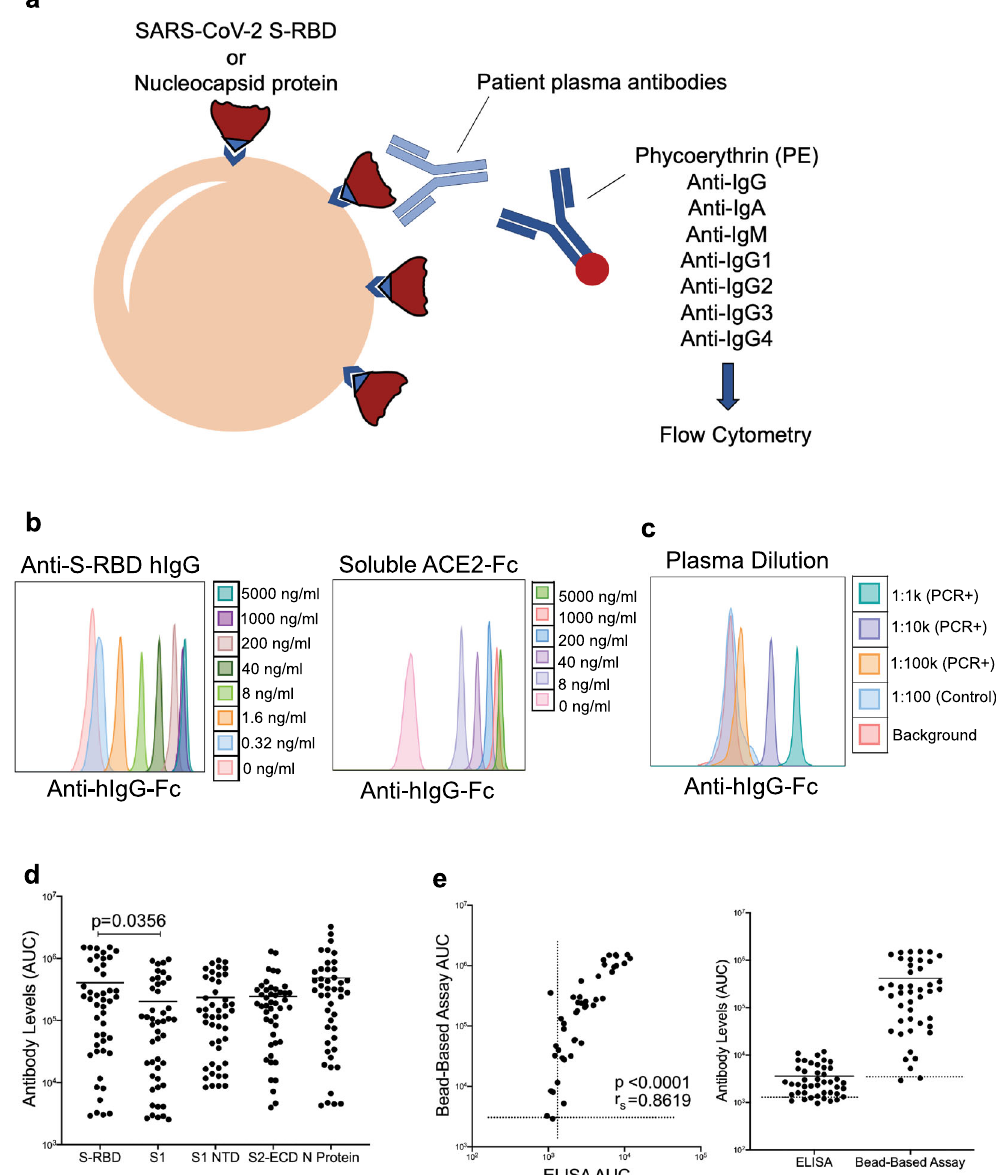
Fig. 1 SARS-CoV-2 speci fi c antibody detection assay. a Illustration of antibody detection assay. Biotinylated S-RBD or Nucleocapsid proteins are captured by streptavidin-coated beads, then incubated with plasma samples and stained with PE-conjugated anti-IgG, IgA, IgM, IgG1, IgG2, IgG3, IgG4 antibodies. Fluorescence intensity analyzed by fl ow cytometry. b Histogram overlays demonstrating the detection of anti-S-RBD human IgG antibody (left) and soluble ACE2-Fc (right) as positive controls for plasma antibody assay. c Representative patient plasma titration. Healthy control plasma at 1:100 dilution was used as a negative control. Serial dilutions were used in the fl ow cytometry overlay. d Comparison of IgG antibody levels captured by S-RBD, S1 subunit of spike, S1 N terminal domain (NTD), S2 extracellular domain (ECD) and nucleocapsid protein coated beads ( n = 46 biologically independent samples). e Correlation and comparison of bead-based assay S-RBD IgG antibody levels with ELISA-based assay ( n = 44). Two-tailed Mann – Whitney U test was used to determine the statistical signi fi cance in ( d ) and two-tailed Spearman ’ s was used for correlation signi fi cance in ( e ). Horizontal bars in ( d ) and ( e ) indicate mean